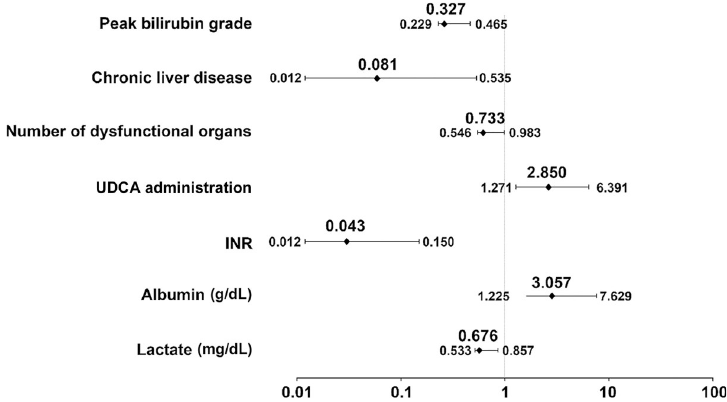
Fig 4. Relative impact of variables on bilirubin recovery (multivariable logistic analysis described with OR and 95% CI). Model 2, multivariable logistic analysis with sex, age, body mass index (BMI), medical history (alcohol drinking, smoking, diabetes mellitus, hypertension, dyslipidemia, chronic liver disease, obstructive jaundice, cancer, hepatic encephalopathy, disseminated intravascular coagulation (DIC), acute on chronic liver failure (ACLF), ischemic heart disease, stroke, hypoxic hepatitis, sepsis, and shock), cardio-pulmonary resuscitation (CPR), extracorporeal membrane oxygenation (ECMO), liver surgery, ursodeoxycholic acid (UDCA), the initial Sequential Organ Failure Assessment (SOFA) score, number of dysfunctional organs, laboratory results, and type of hyperbilirubinemia. Abbreviation: Bilirubin recovery, bilirubin decrease below 6 mg/dL; OR, odds ratio; CI, confidence interval; UDCA, ursodeoxycholic acid; INR, international normalized